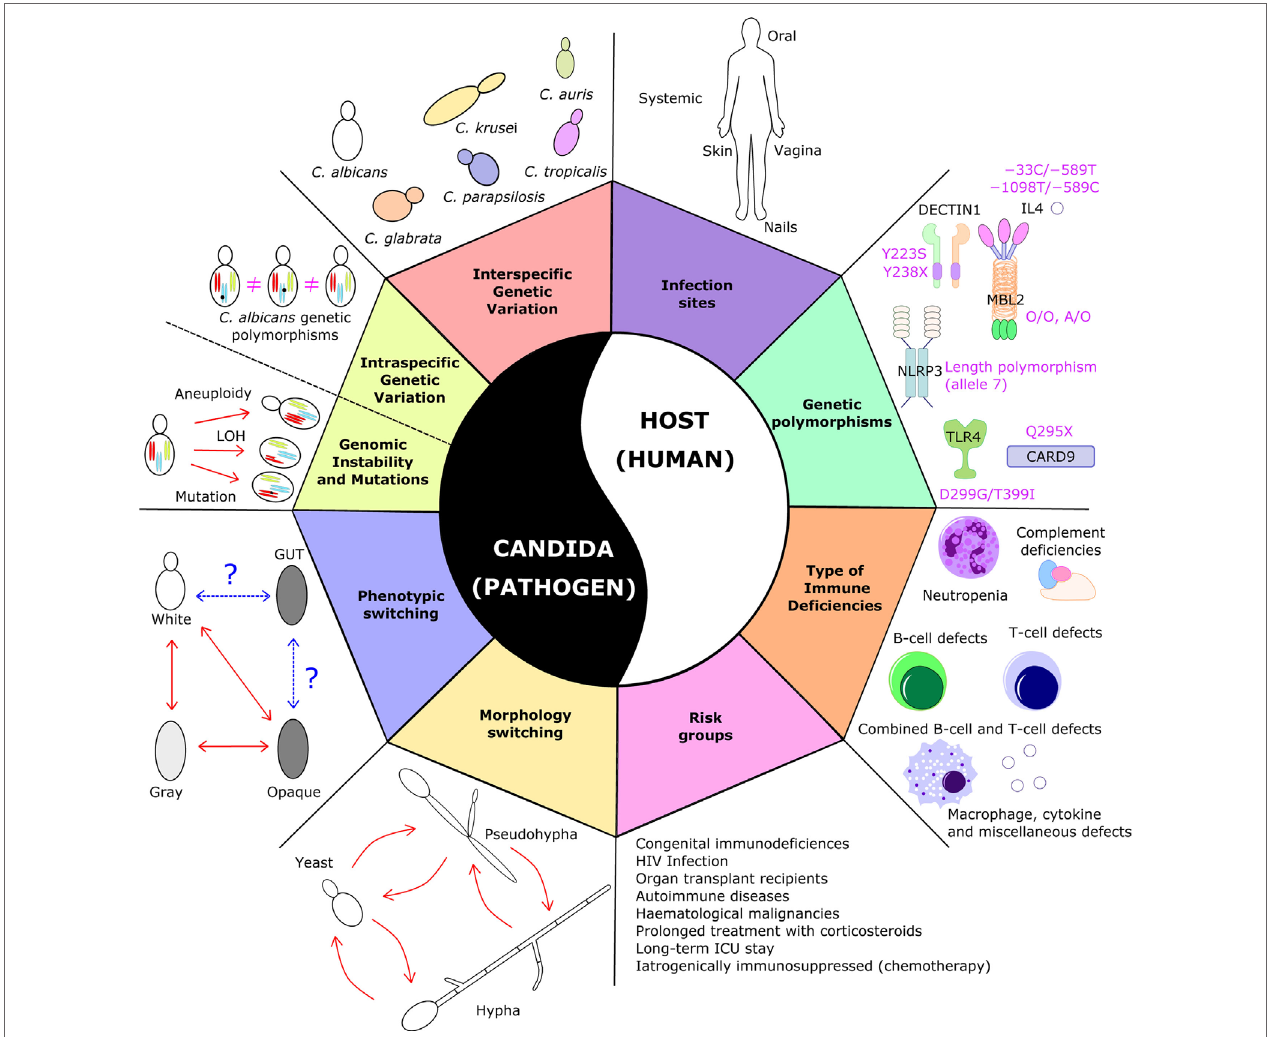
FiGURe 1 | Sources of variability in Candida -related infections. The figure illustrates the plethora of variations at the level of the pathogen and the host, which pose serious challenges in the development of an antifungal vaccine. On the pathogen side, Candida species display large phenotypic, morphological, and genetic variation and dynamics; on the host side, candidiasis can occur in different types of patients, with different types of immune system dysfunction or carrying different genetic polymorphisms, and in different anatomical sites. Taken together, this broad and diverse clinical spectrum of the disease makes it difficult to design a “one-size-fits-all” vaccine that would protect all these different patients from all these different types of fungal